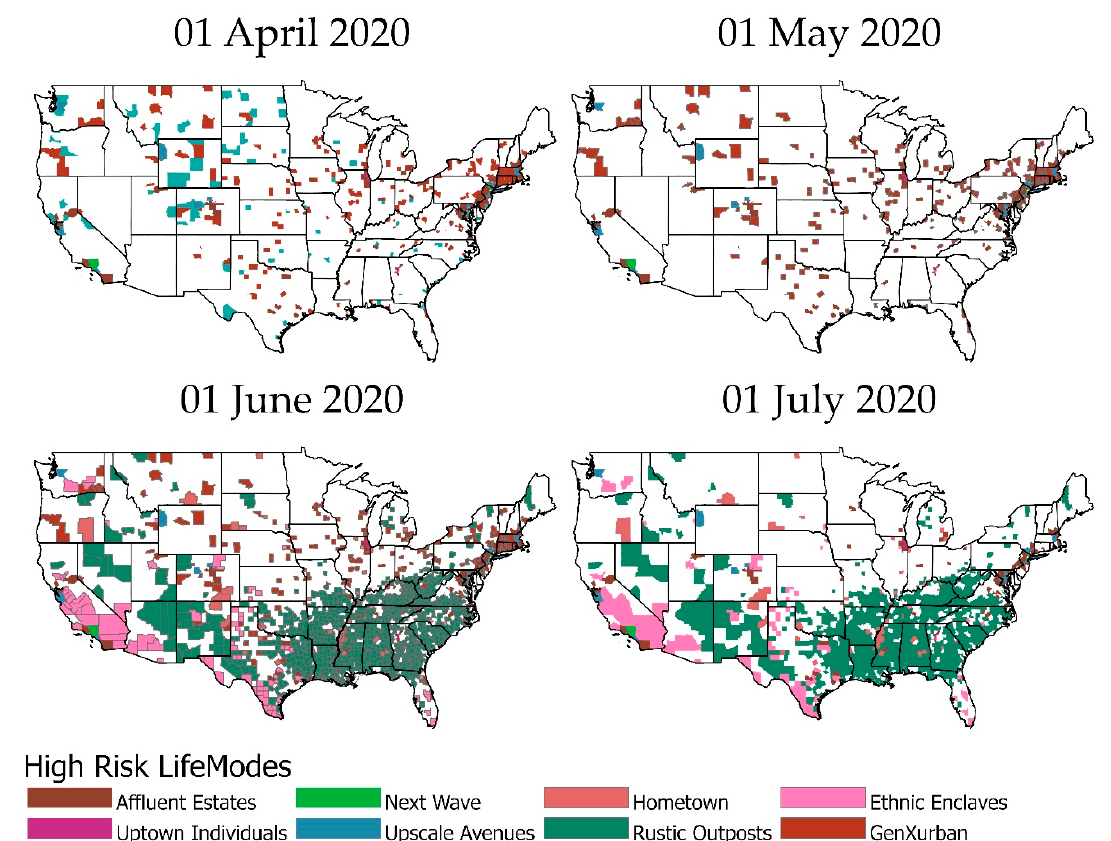
Figure 5. High-risk LifeModes from 1 April to 1 July 2020.